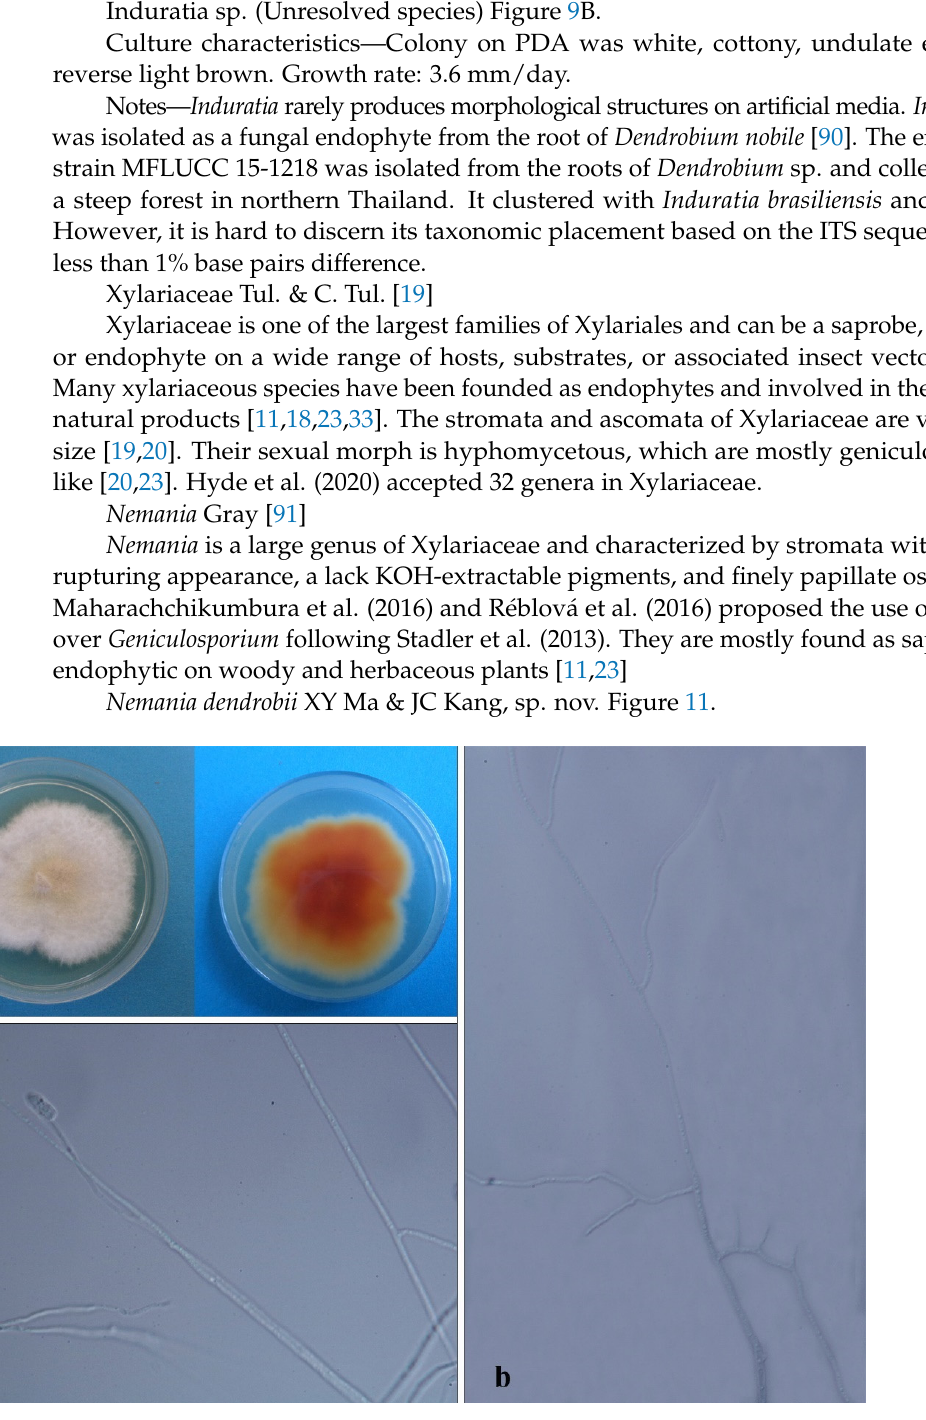
Figure 11. Nemania dendrobii (GZAC O49S1A) ( a ) Colony on PDA (MFLUCC 18-1213) (left-front view, right-reverse view). ( b ) Mycelia. ( c ) Conidiophore with conidia. Notes: ( b , c ) on WA.